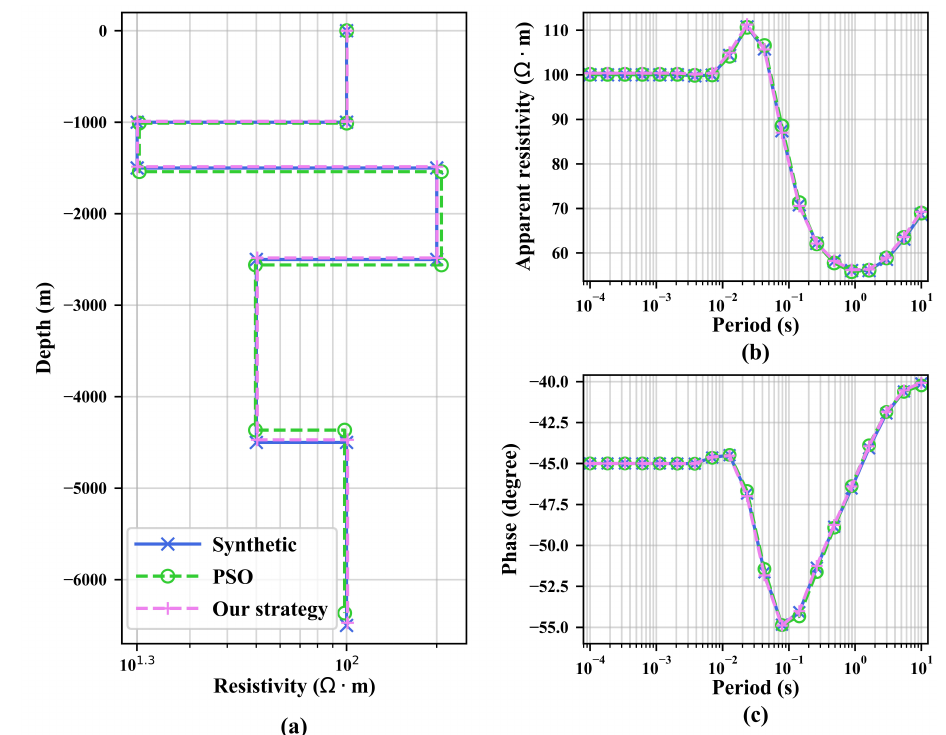
Figure 6. The five-layer geoelectric model and its MT response predicted by traditional PSO and our strategy. ( a – c ) represent the geoelectric model, apparent resistivity responses and represent phase responses, respectively. The blue lines represent the supposed three-layer geoelectric model and its MT responses. The green lines represent the geoelectric model predicted by traditional PSO and its MT responses. The purple lines represent the geoelectric model predicted by our strategy and its MT